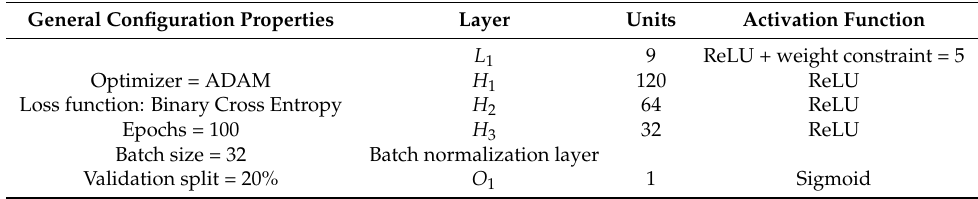
Table 5. Settings and parameters for SAE